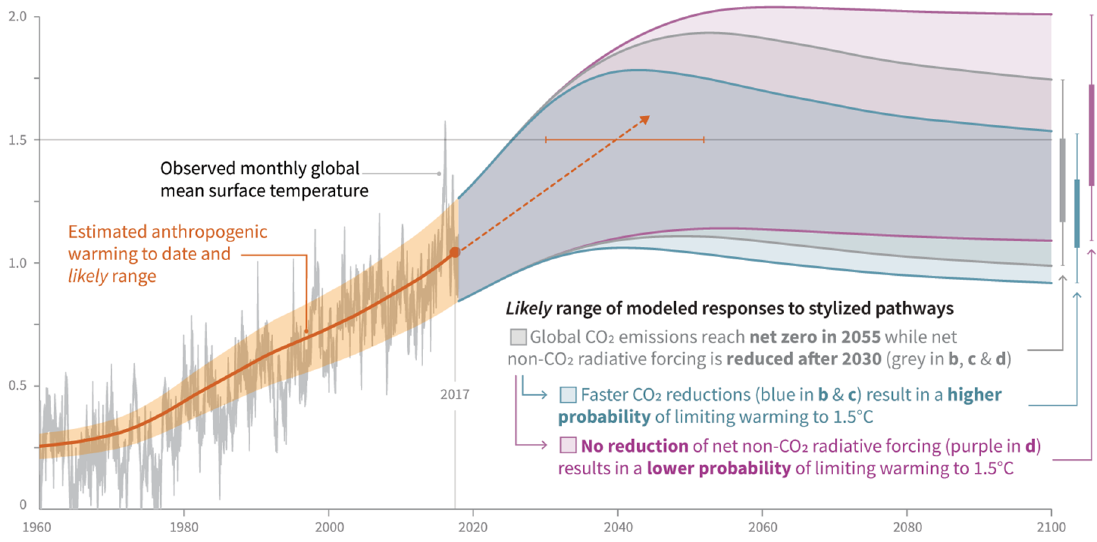
Figure 1. Observed and projected global temperature change based on different emission scenarios; global warming is relative to 1850–1900 (°C) [1].